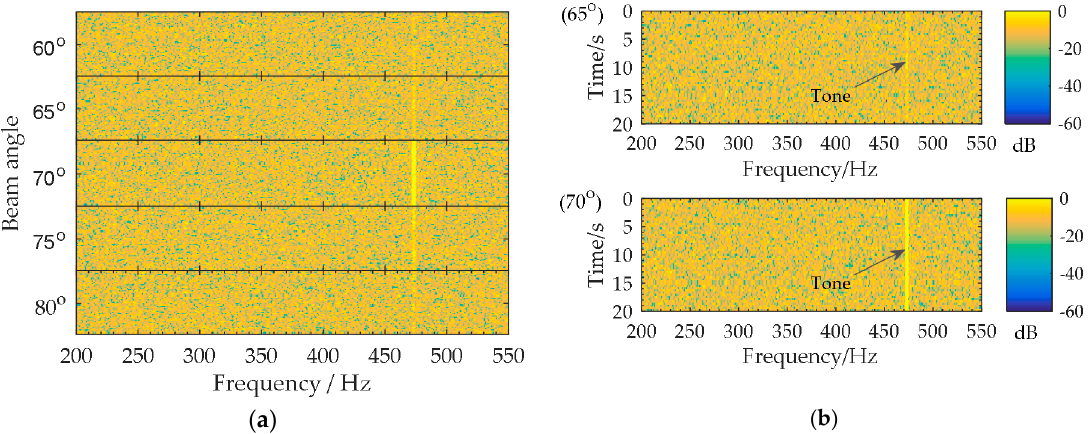
Figure 3. Multi-beam lofargram analysis: ( a ) Multi-beam lofargram; ( b ) The lofargrams in ( a ) corresponding to the beam angles of 65° and 70°.